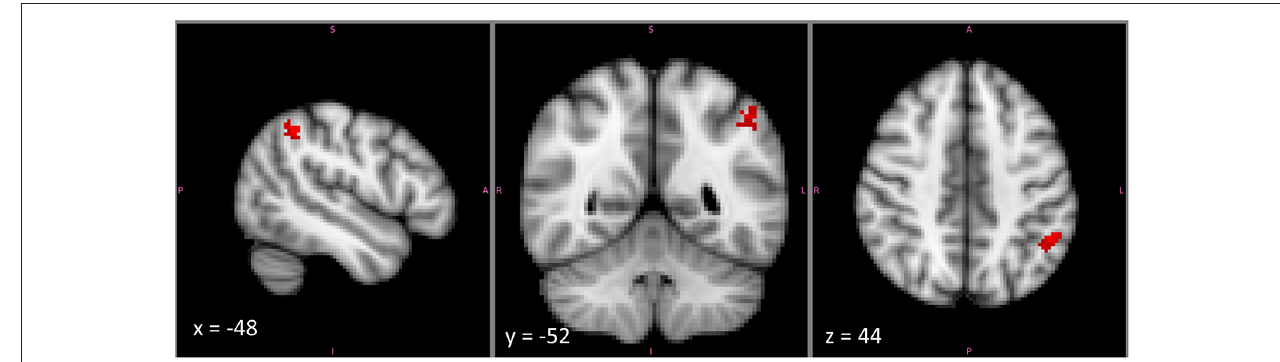
FIGURE 6 | The cluster within left mid-IPL (IPLc and IPLd) that was associated exclusively with reasoning and with no other examined term . This cluster lies on the upper part of the ventral bank of the intraparietal sulcus. Note that the image is displayed in radiological coordinates, with left and right